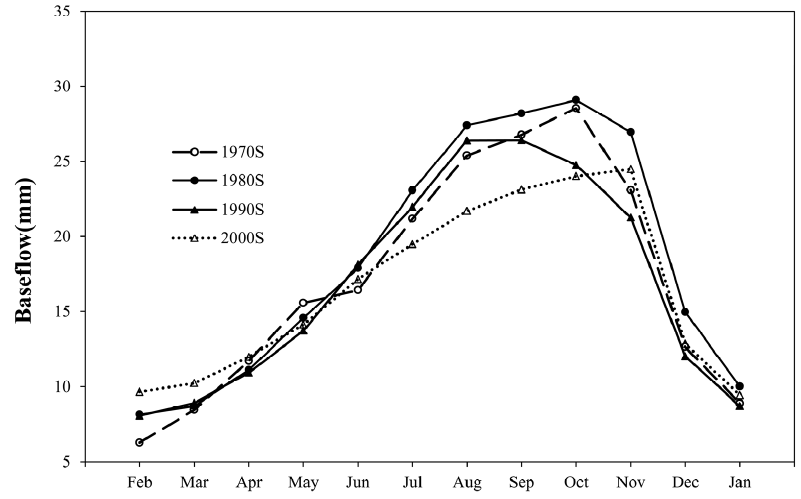
Figure 4. Watershed ‐ scale average monthly baseflow for the 1970s, 1980s, 1990s, and 2000s.